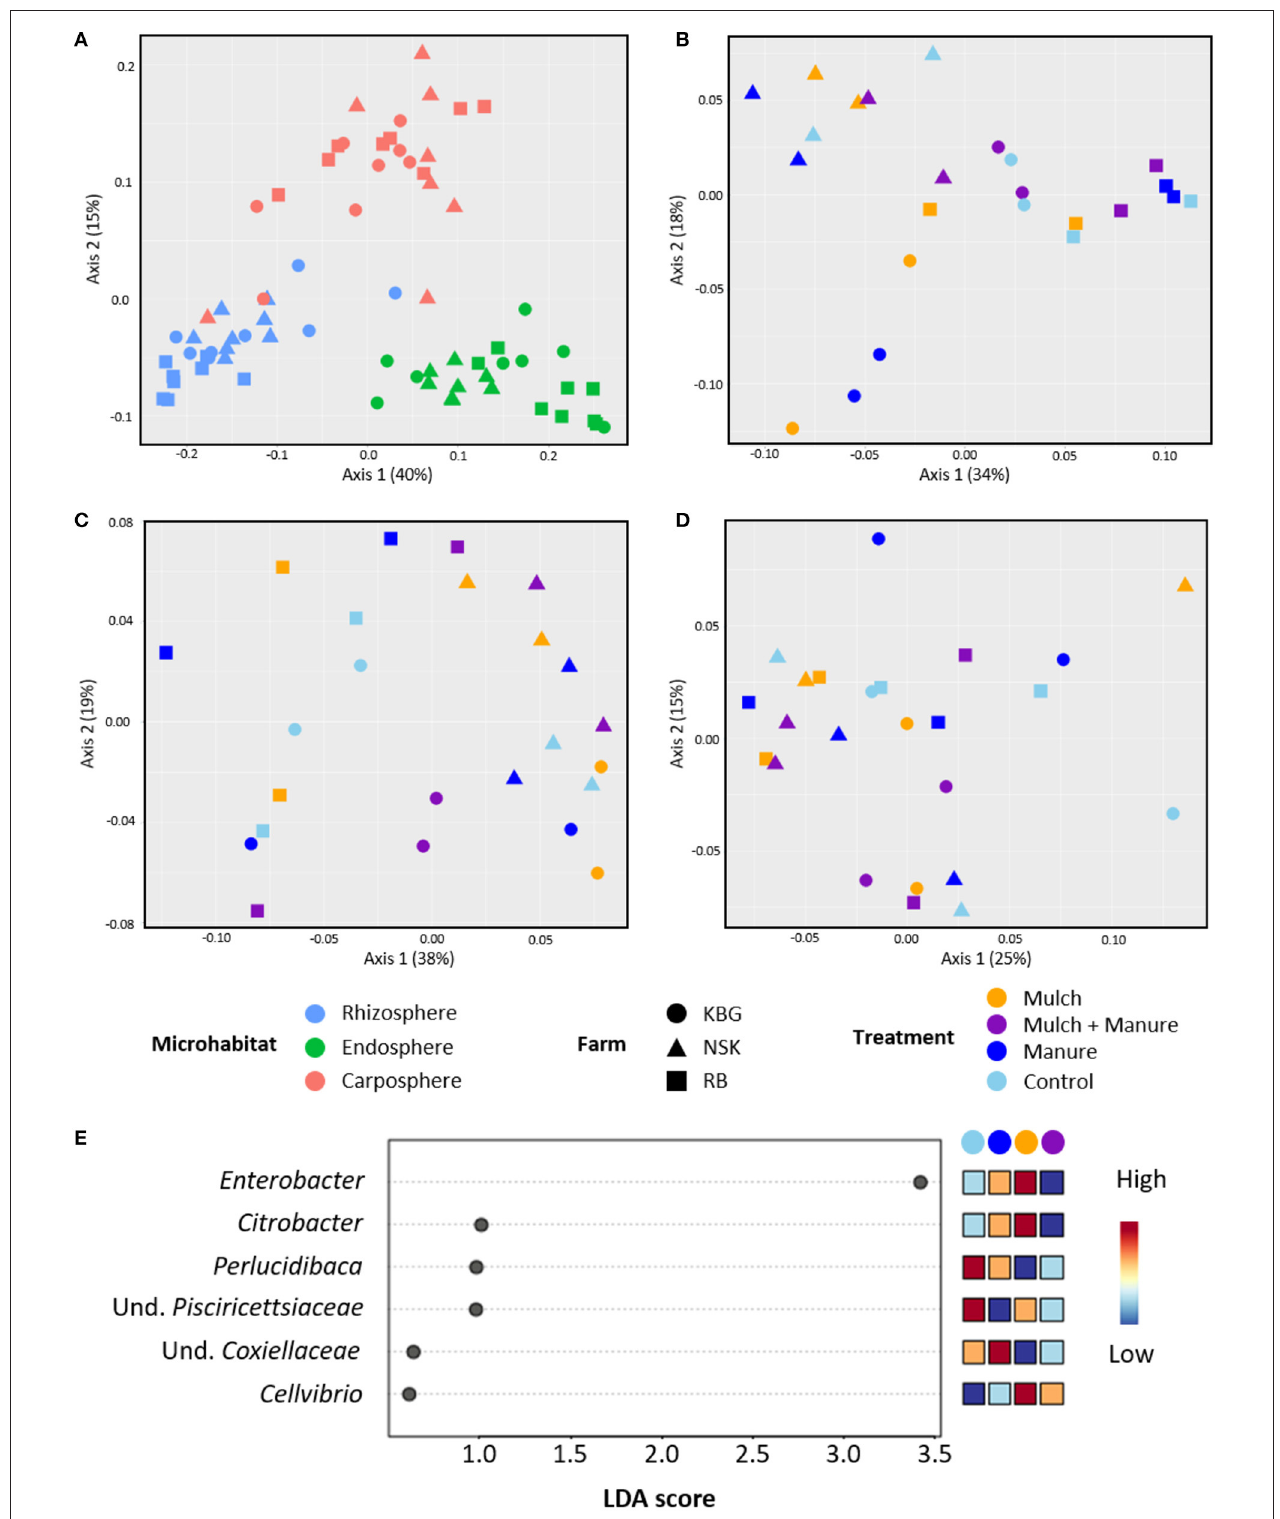
FIGURE 4 | Principal coordinate analysis (PCoA) plots of the gammaproteobacterial communities inhabiting all microenvironments (A) , rhizosphere (B) , pseudostem endosphere (C) , and carposphere (D) of banana plants grown at three different farms (RB, NSK, and KBG) in Uganda under varying organic management regimes. Linear discriminant analysis effect size (LEfSe) analysis identifying considerably different taxa between treatments in the rhizosphere across all locations (E) . PCoA plots are based on weighted UniFrac distances. The plots indicate the grouping of samples by the farm (different shapes) and individual treatments (different colored